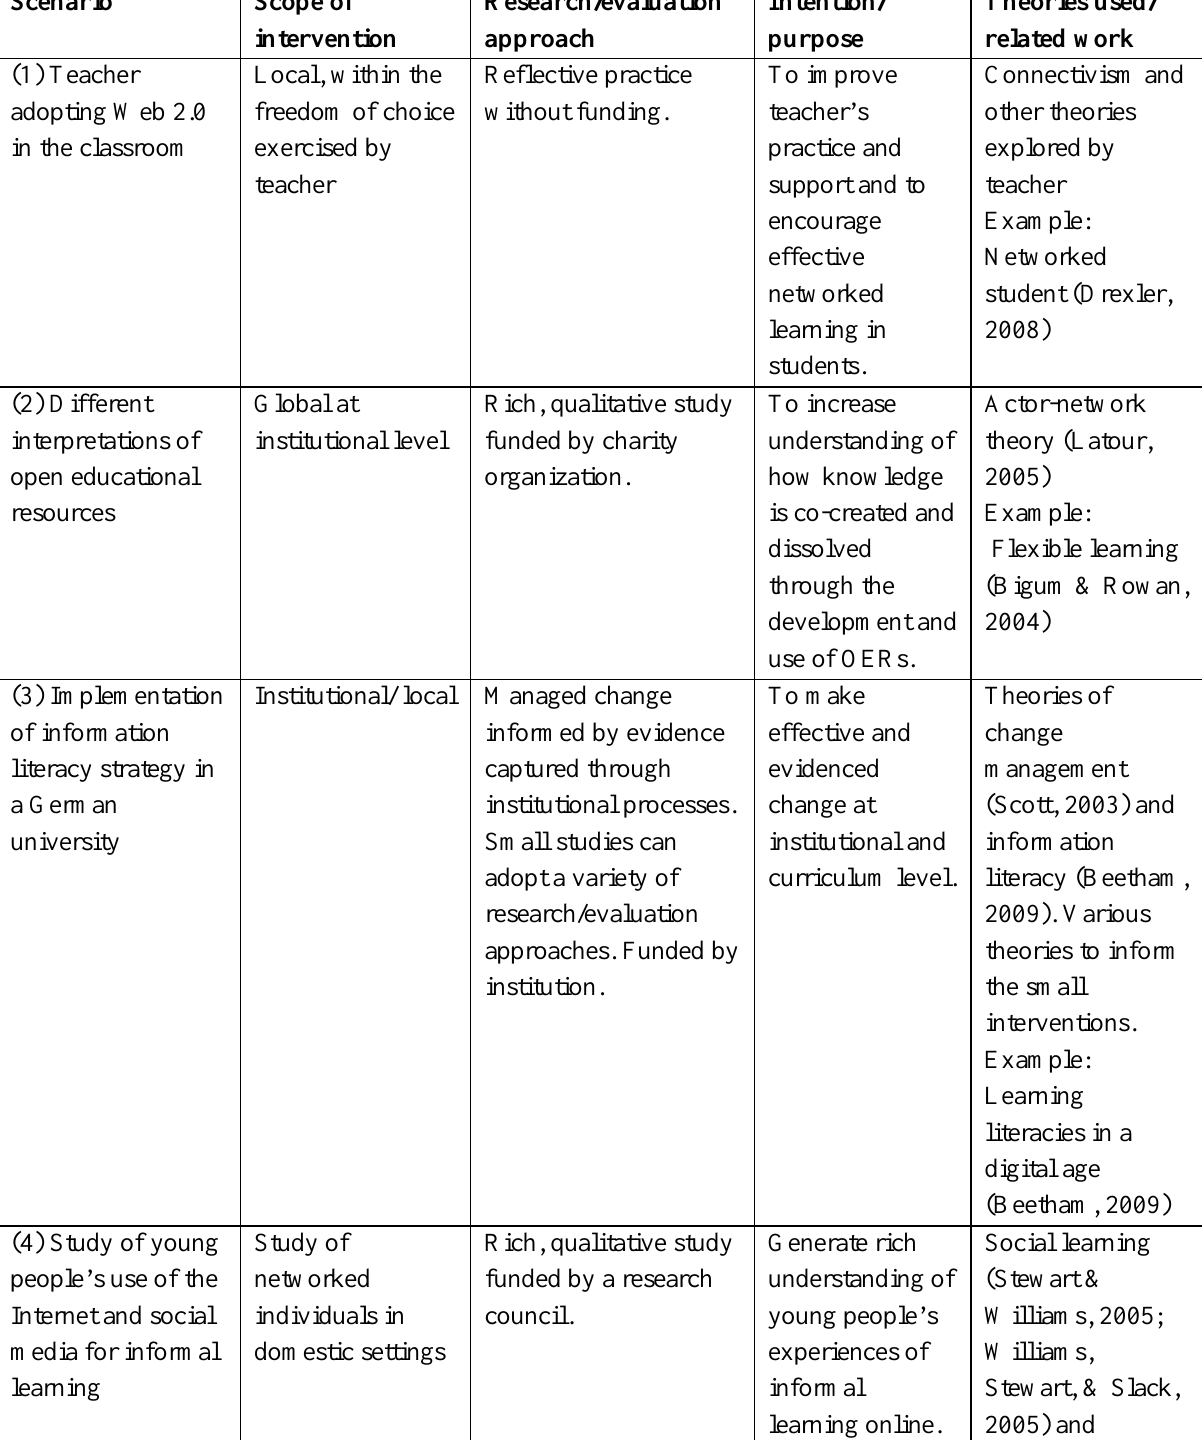
Table 2 Summary of Key Features of Alternative Research/Evaluation Scenarios